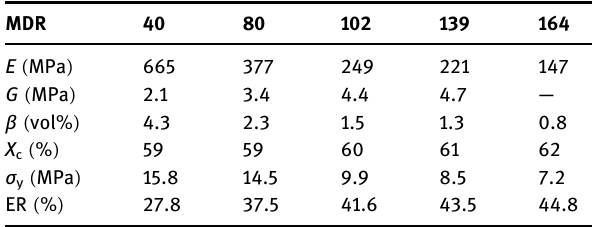
Table 1: The mechanical parameters of cast fi lms prepared at dif